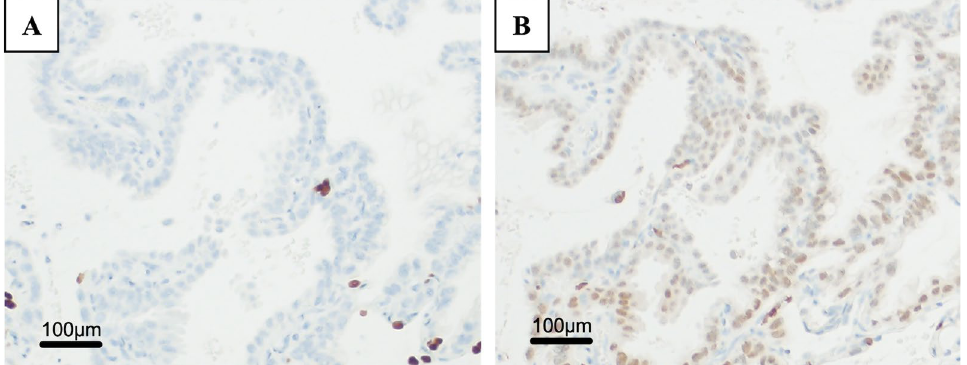
Fig. 5 Macroscopic images of the resected lung metastasis by low power field. A Negative for thyroid transcription factor-1 staining ( Positive for paired box 8 staining